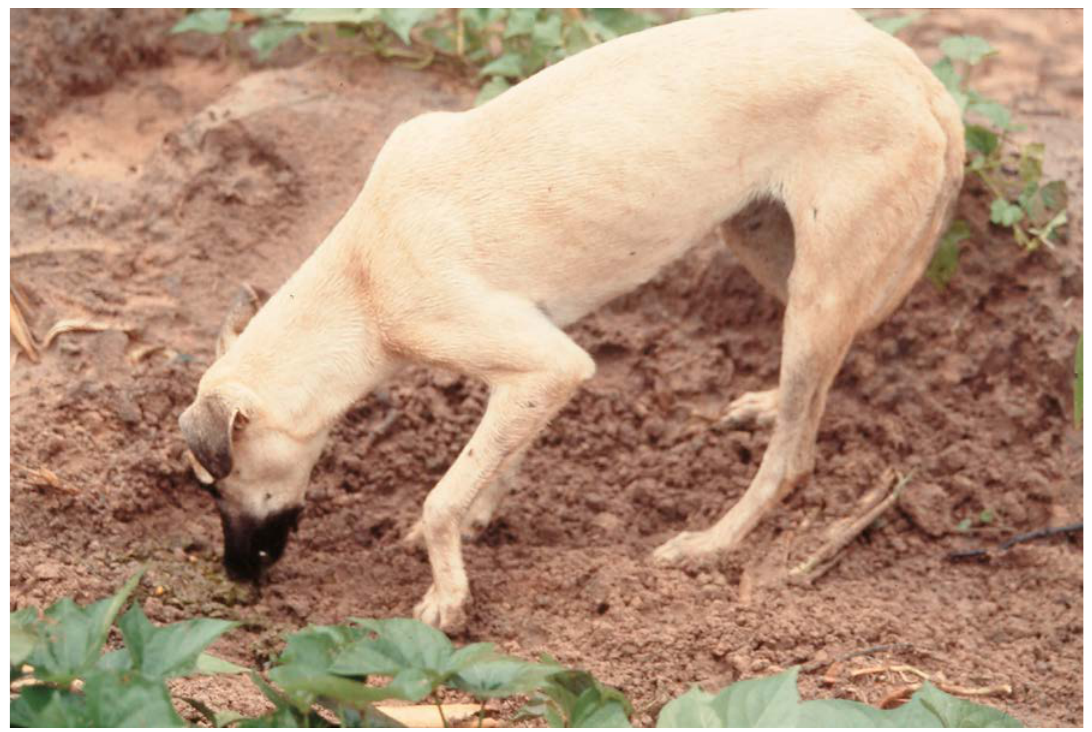
Figure 4. A free-ranging dog uncovering and eating human faeces buried in a field. This animal represents condition score 4 (photo: James Butler).